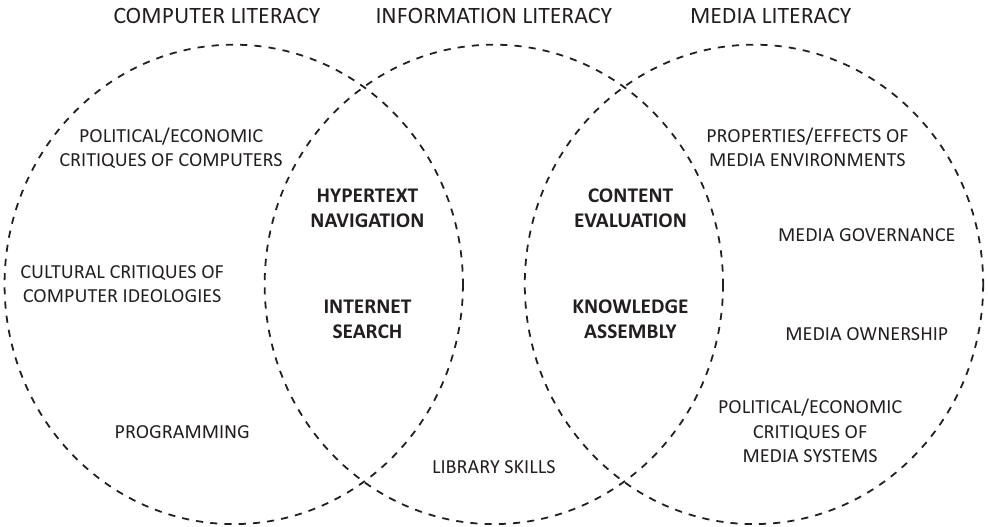
Figure 3. Gilster’s taxonomy of digital literacy, emerged at the common intersections of computer, information, and media literacy